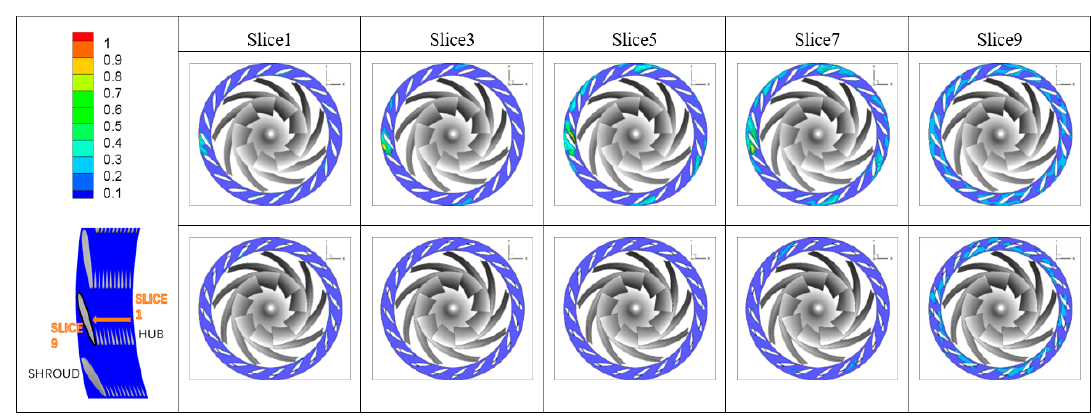
Figure 13. Comparison of stall cell 3D distribution in the guide vane before and after using the “Groove Method.”